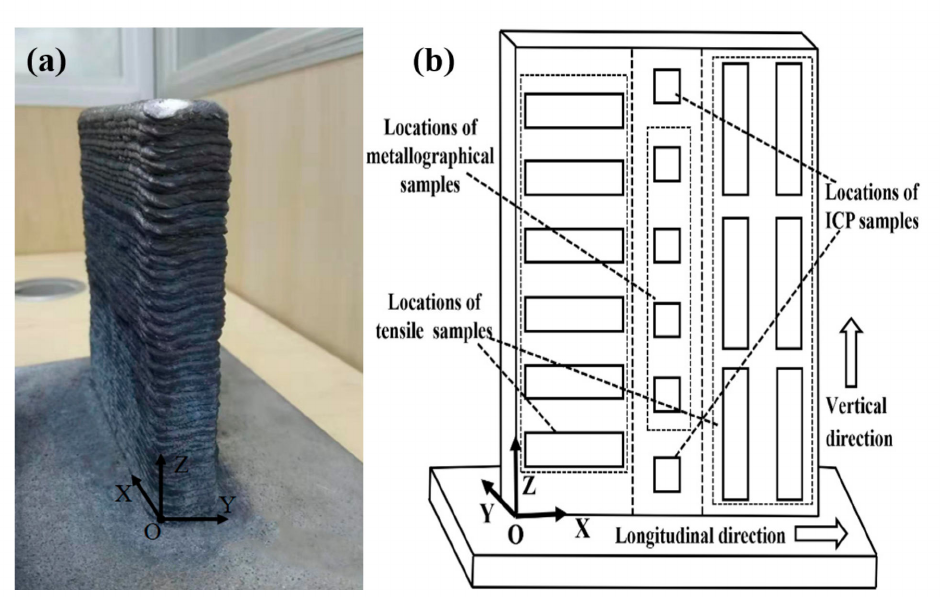
Figure 2. ( a ) WAAM-CMT printed TiB 2 /AlSi7Mg0.6 sample; ( b ) extraction locations of specimens and definition of X, Y, and Z directions.